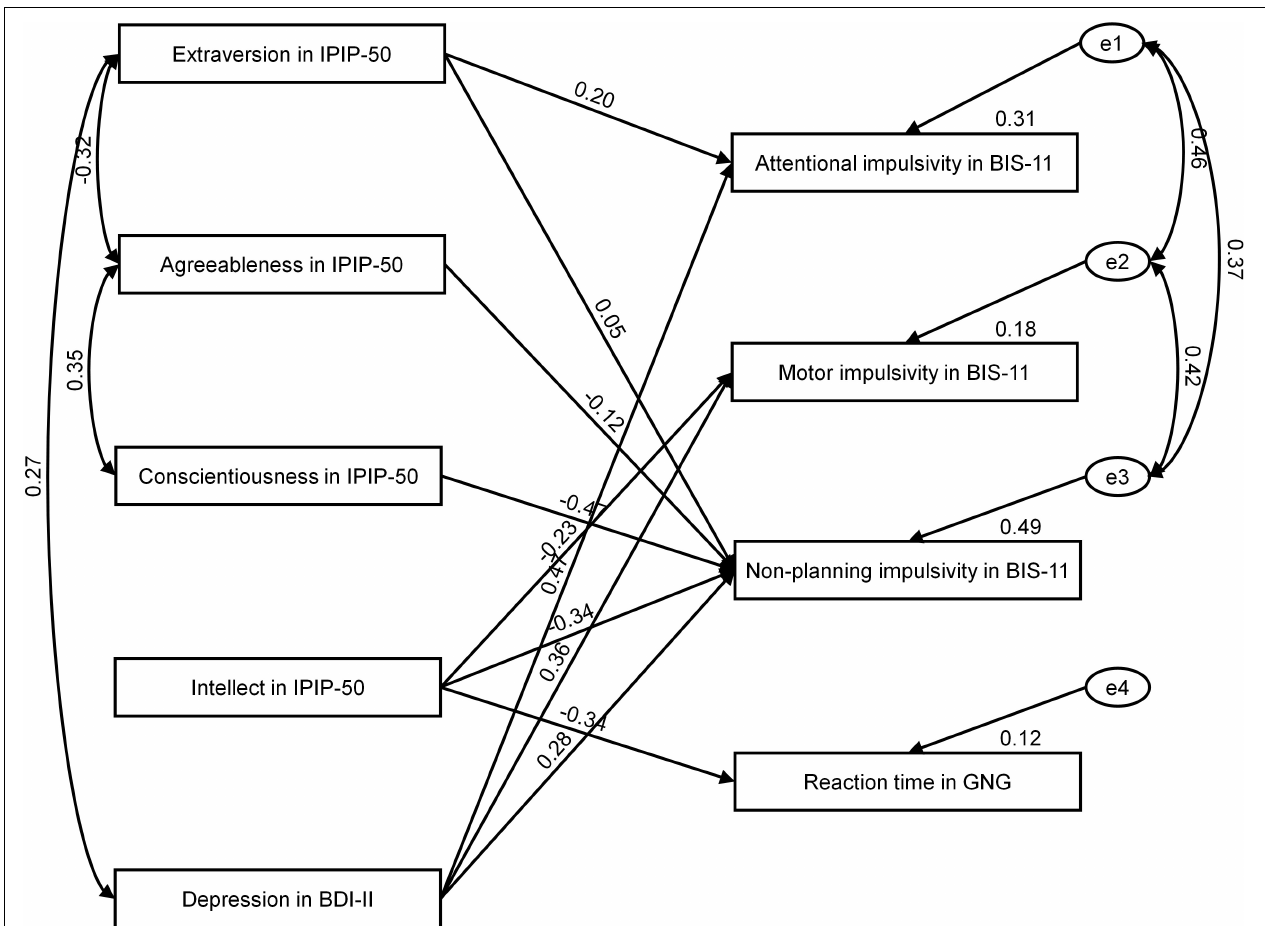
Estimate Lower Upper